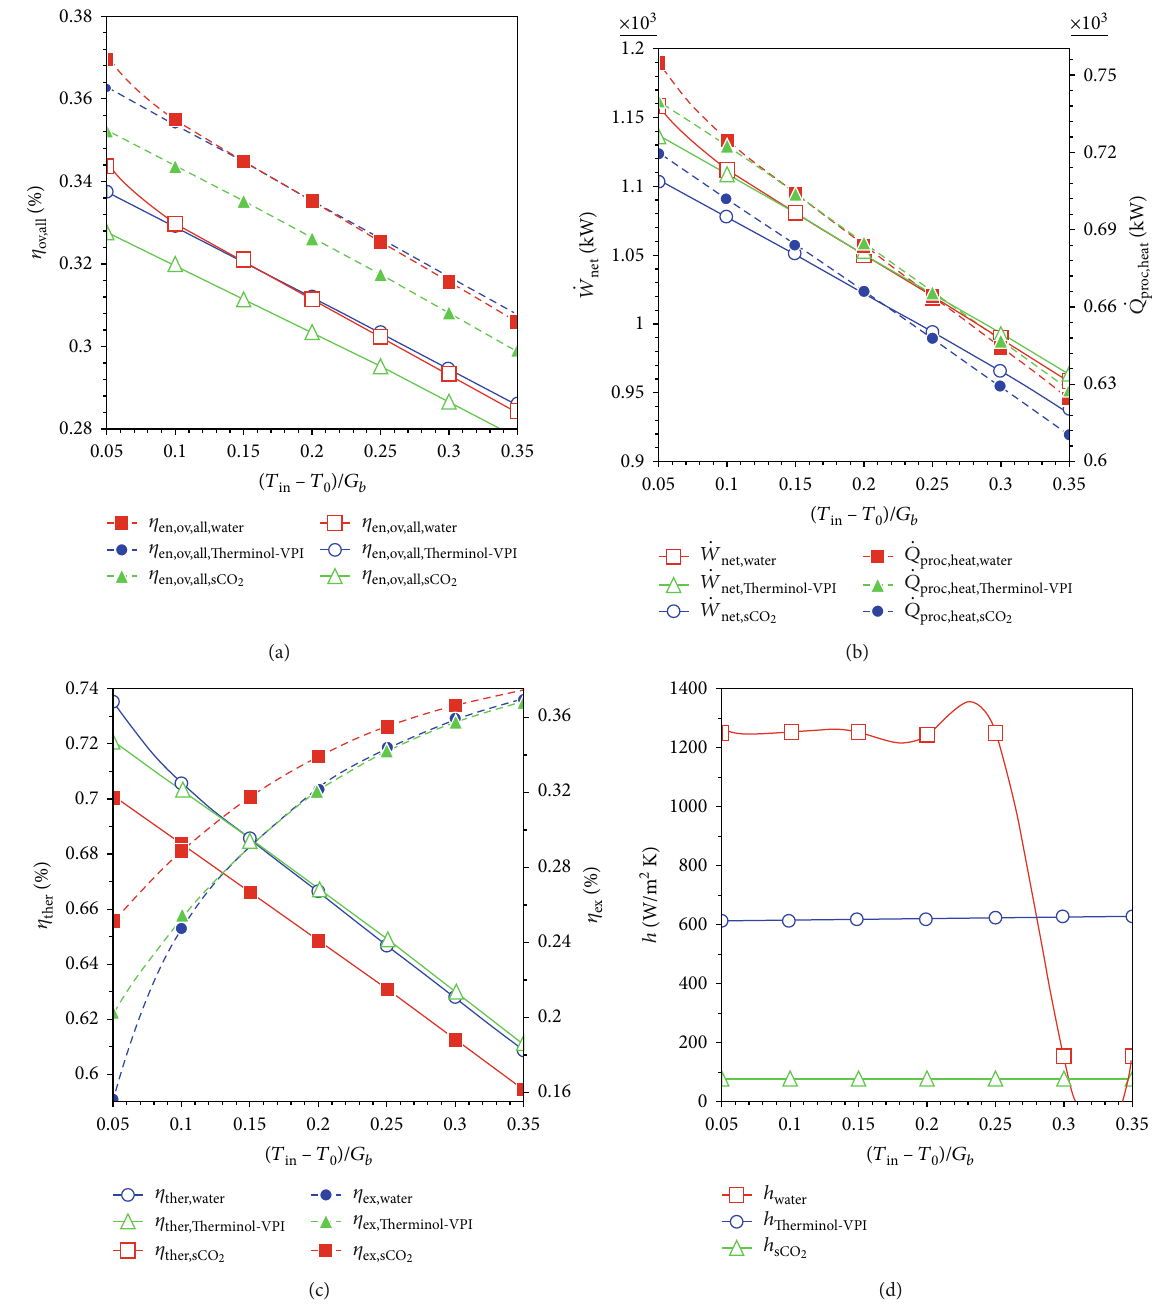
Figure 5: E ff ect on Inlet temperature on (a) integrated e ffi ciencies, (b) net work output and process heating, (c) thermal and exergy e ffi ciencies, and (d) heat transfer coe ffi